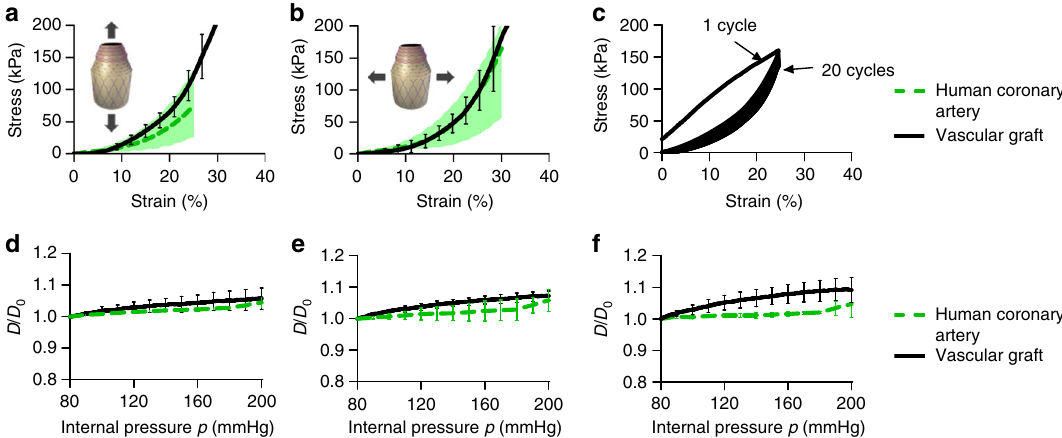
Fig. 6 Mechanical evaluation of the fabricated small diameter vascular graft (SDVG). a , b Stress – strain curves of the SDVG (black line) and the human coronary artery in a longitudinal and b circumferential stretching directions ( n = 5 independent experiments). The green dashed lines and green shaded zones in a and b represent average and value range, respectively 35 . The green shaded zones represent the range of results obtained for native human coronary arteries 35 . c Cyclic tensile testing in the circumferential direction. d – f Pro fi les of diameter change ratio ( D / D 0 ) as function of pressure applied to the SDVG (black line, n = 5 independent experiments) compared with human coronary arteries (green dashed lines, n = 5 independent experiments) 34,35 at three different values of axial pre-stretch during testing ( e z ). d e z = 10% of axial pre-stretch. e e z = 20% of axial pre-stretch. f e z = 25% of axial pre- stretch. Error bars = standard